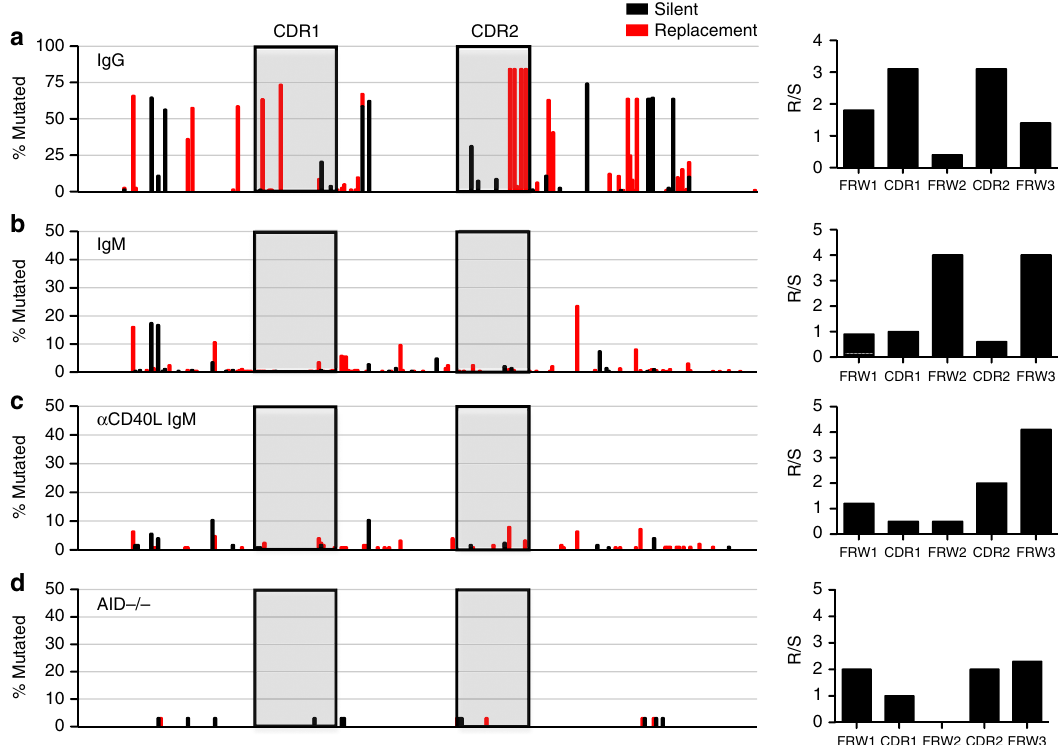
Figure 5 | IgM heavy chain mutations are not enriched in CDR regions and show no evidence of antigen selection. Mutational frequency or replacement (in red) and silent mutations are plotted for IgHV186.2 regions of IgG ( a ) and IgM ( b ) PCs, as well IgM PCs with a CD40L blockade ( c ) and AID (cid:2) / (cid:2) IgM PCs ( d ), with replacement to silent amino acid changes (R/S ratios) given to the